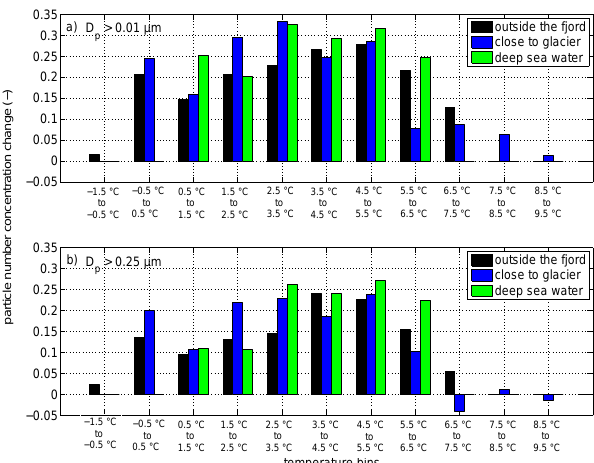
Fig. 7. Comparison of warming experiments with their re- lated cooling experiments using sea water from outside the fjord (W1=warming experiment 1, C1=cooling experiment 1, W2=warming experiment 2, C2=cooling experiment 2). The same markers indicate two related types of water. Dashed lines are the 25th and 75th percentiles. Red solid lines represent experiments with increasing water temperature and blue solid lines experiments with decreasing water temperature. (a) Medians of particle number concentration with D p > 0 . 01µm. (b) Medians of particle number concentration with D p > 0 .